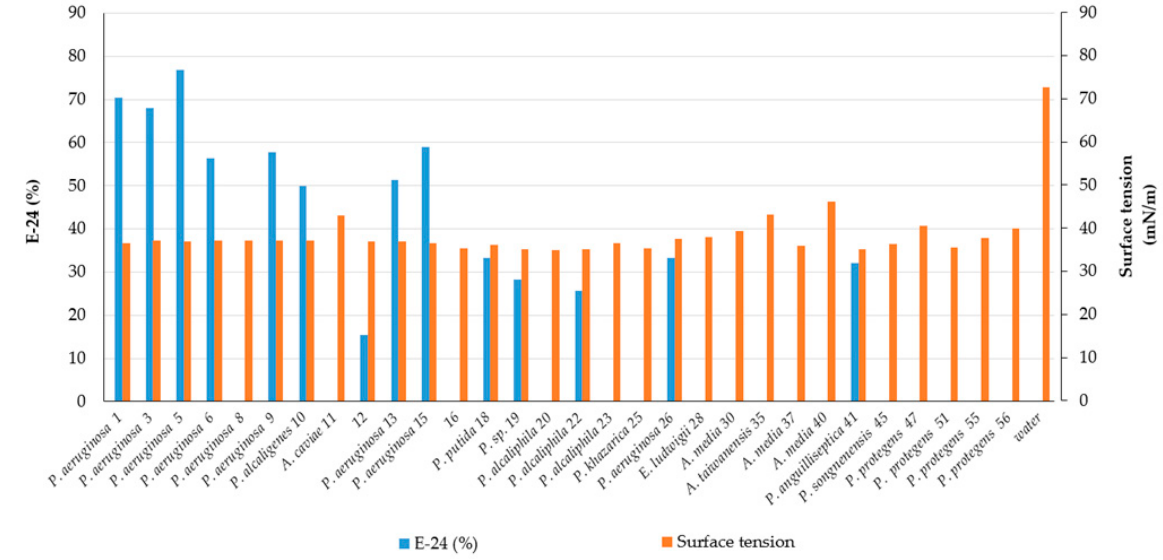
Figure 1. Emulsification index E-24(%) and the surface tension activity (mN · m − 1 ) of intestinal bacterial cultures from mullet